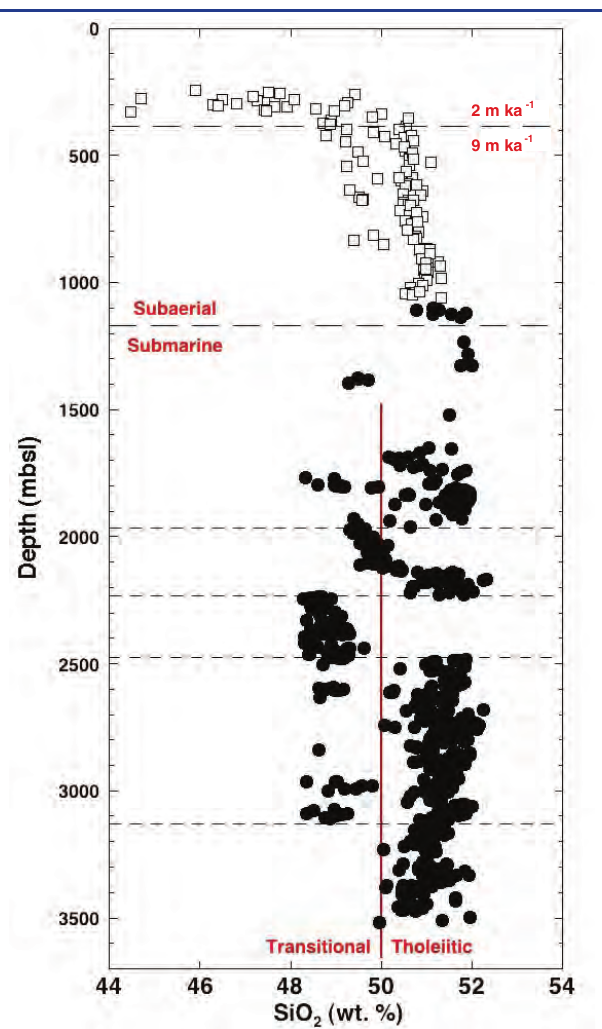
Figure 5. SiO 2 contents of Mauna Kea lavas and hyaloclastites plotted versus depth below sea level in the HSDP core. Solid symbols are glass samples, open symbols are whole rock measurements adjusted for crystal fractionation and accumulation to MgO content of 7% by weight. Below 1350 mbsl there is a bimodal distribution of SiO 2 concentrations indicative of two distinct magma types. Short horizontal dashed lines separate subsections of the core where one or the other lava type predominates. In the uppermost subaerial portion of the core a systematic decrease in the SiO 2 concentration, representing the tholeiitic to alkaline transition, is also associated with a pronounced decrease in the local lava accumulate rate from 9 m ka -1 to 2 m ka -1 (see Figs. 6 and 7). Data from Rhodes and Vollinger (2004), Stolper et al. (2004), and unpublished data.